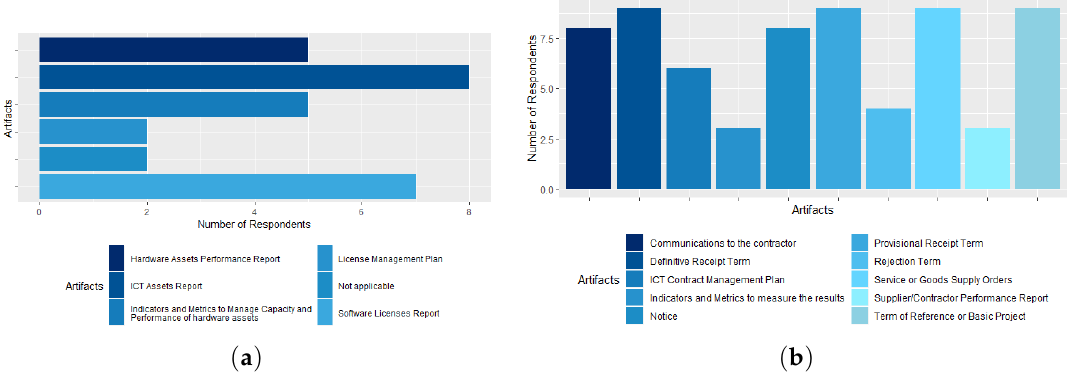
Figure 14. ( a ) The Manage ICT Assets (Hardware, Licenses and Costs) process artifacts; ( b ) the ICT Contract Management process